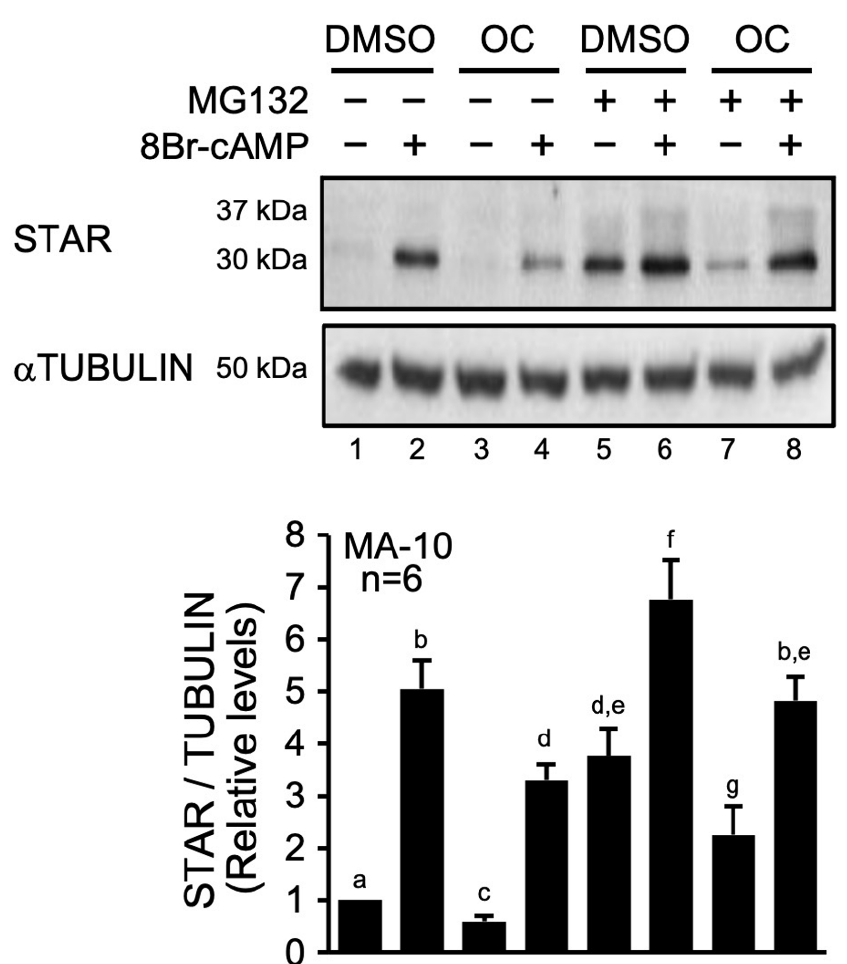
Figure 1. The OC mixture affects STAR protein levels in MA-10 Leydig cells by acting on the protein degradation pathway. MA-10 Leydig cells were treated with either dimethylsulfoxyde (DMSO) or 10 µg/mL of an environmentally relevant mixture of OCs for 2 h and then treated for another 4 h with (+) or without ( − ) of 0.1 mM 8Br-cAMP and 10 µM MG132 (an inhibitor of protein degradation) as indicated, and STAR protein was detected by Western blot. α TUBULIN was used as a loading control. The experiment was repeated six times, and the results from each experiment were quantified and plotted as mean ± SE of the mean. Different letters indicate a statistically significant difference between groups ( p < 0.05).